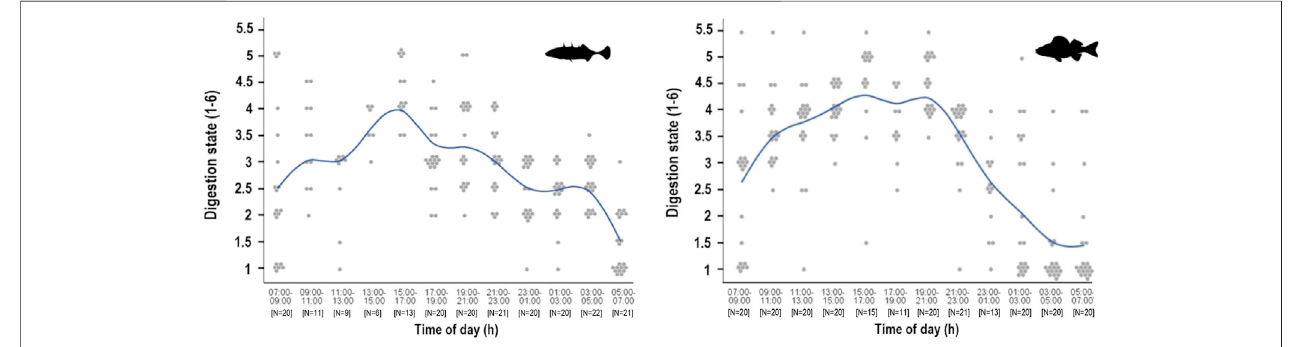
FIGURE 5 | Digestion state during the 24-h cycle of stickleback (left) and perch (right) from Lake Constance in autumn 2018. Digestion state of the diet was estimated from 1(totallydigested/stomachempty) to6(noapparentdigestion). The function lineshows the course ofthedigestionstate means, whilethepoints are the actual total digestion classi fi cation value of each investigated